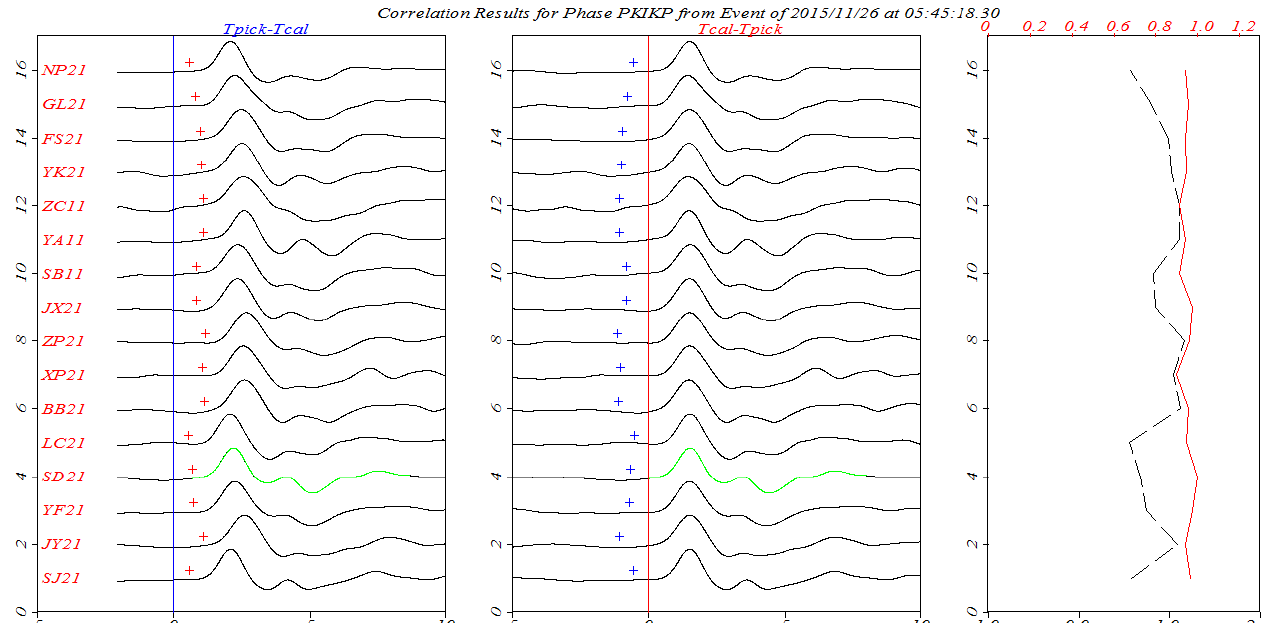
Figure 9. Cross-correlation evaluation system of seismic records in the Alo Islands. (The ( left ) figure shows the waveform with the theoretical arrival time of 0 line; the ( middle ) figure shows the wave- form with the measured arrival time of 0 line; the red solid line in the ( right ) figure shows the cor- relation coefficient. The coordinate axis is the upper red coordinate, the black dashed line is the relative travel time residual, and the coordinate axis is the lower black coordinate in seconds; the station SB11 is selected as the reference wavelet, and its correlation coefficient is 1).